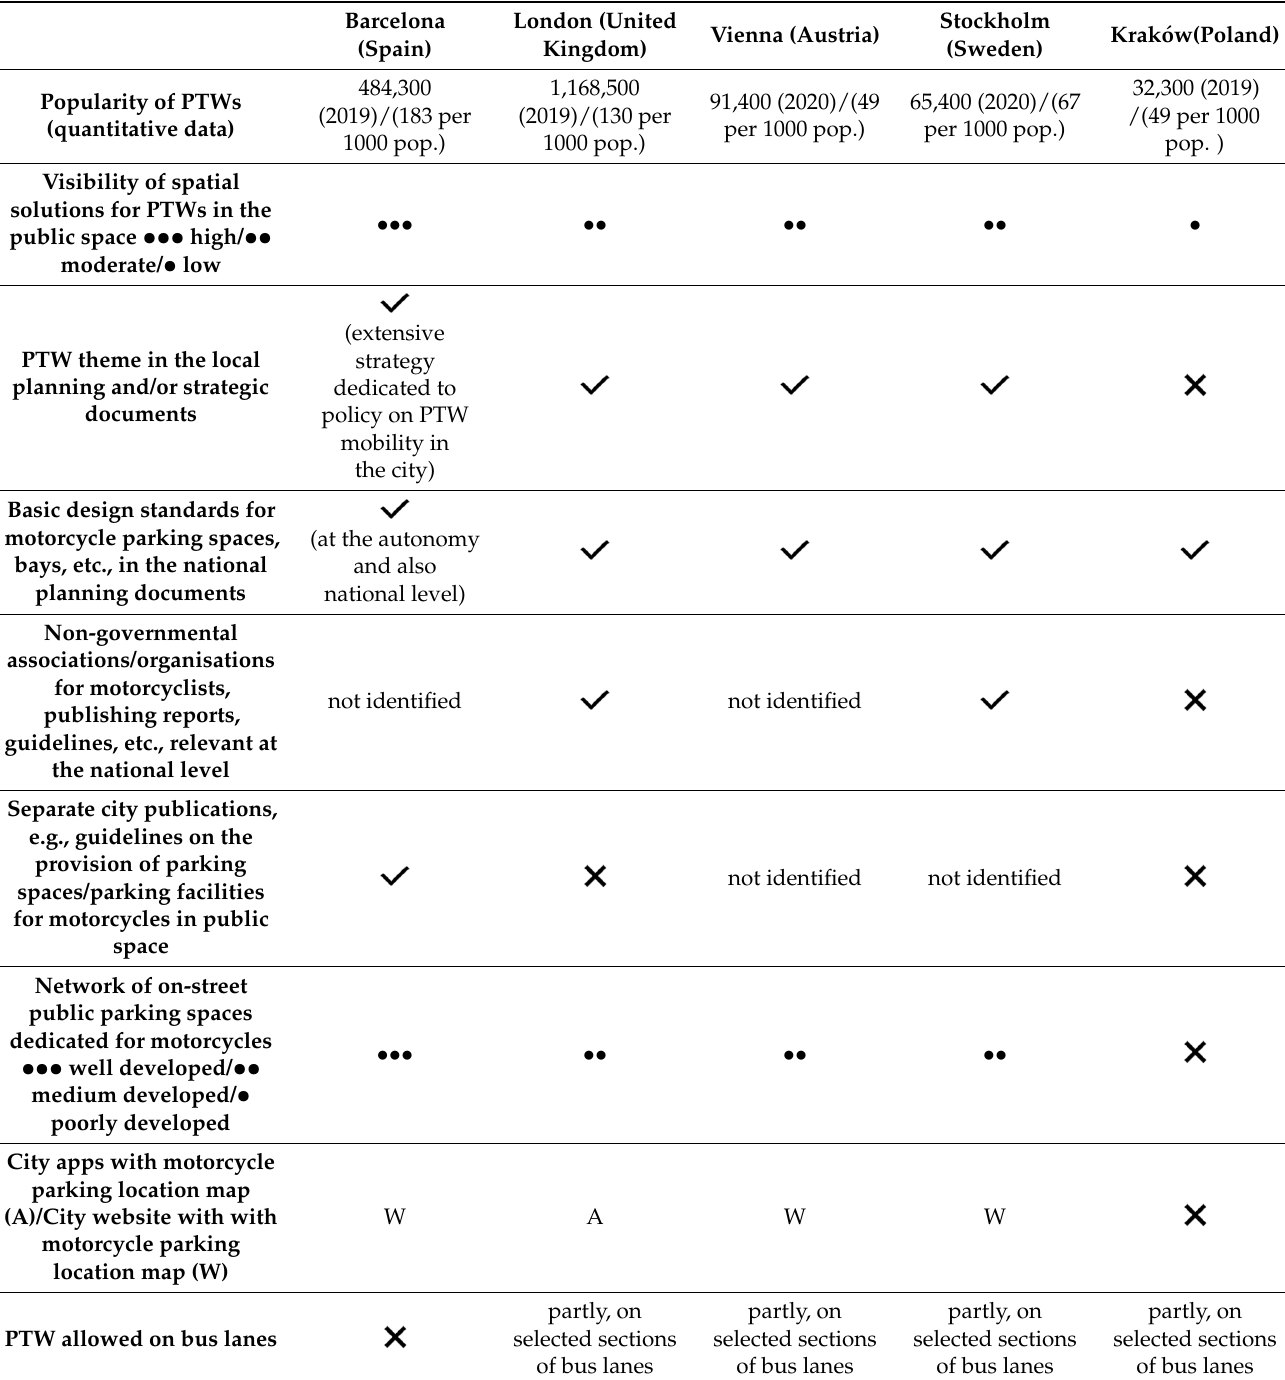
Table 1. Matrix presenting a comparative summary of the main elements of the analysis of the PTW situation in selected European cities. Author: D. Wantuch-Matla.